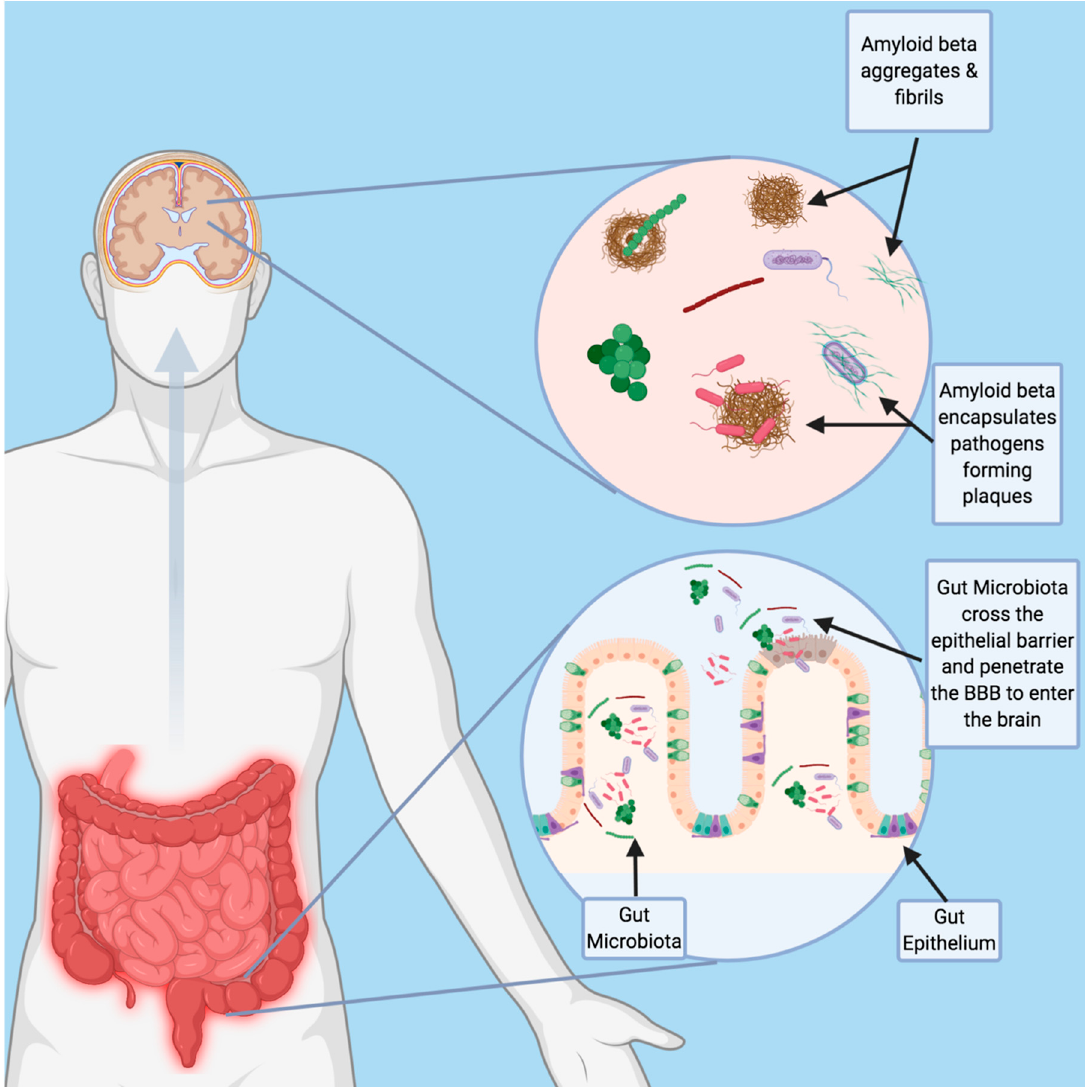
Figure 2. Potential Role of Gut Bacteria in Neurodegeneration. Age-related changes in intestinal permeability and blood brain barrier integrity may allow for penetrance of gut bacteria into the brain and promote the formation of amyloid fibrils. Future studies should focus on the role of gut bacteria as a potential trigger to the amyloid cascade.